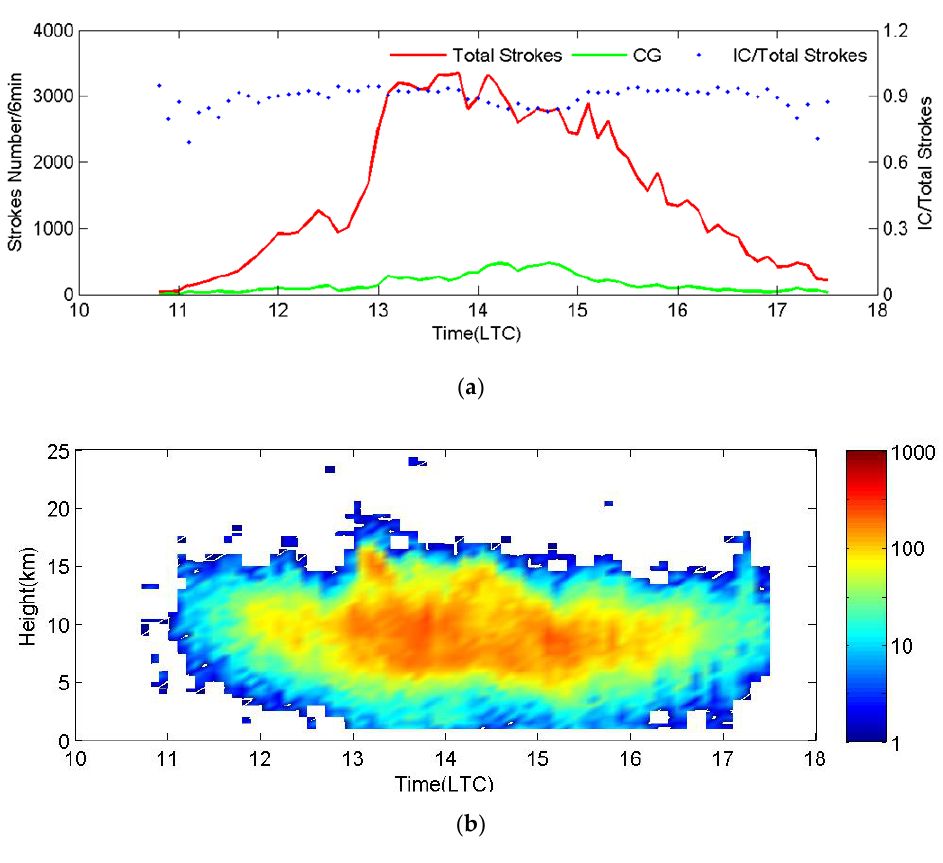
Figure 14. ( a ) Time series of total strokes, CG stroke numbers and IC/total strokes ratio on 19 August 2014 in the discrimination area as shown in Figure 13. ( b ) Vertical distribution of stroke numbers for the same events as in ( a ).